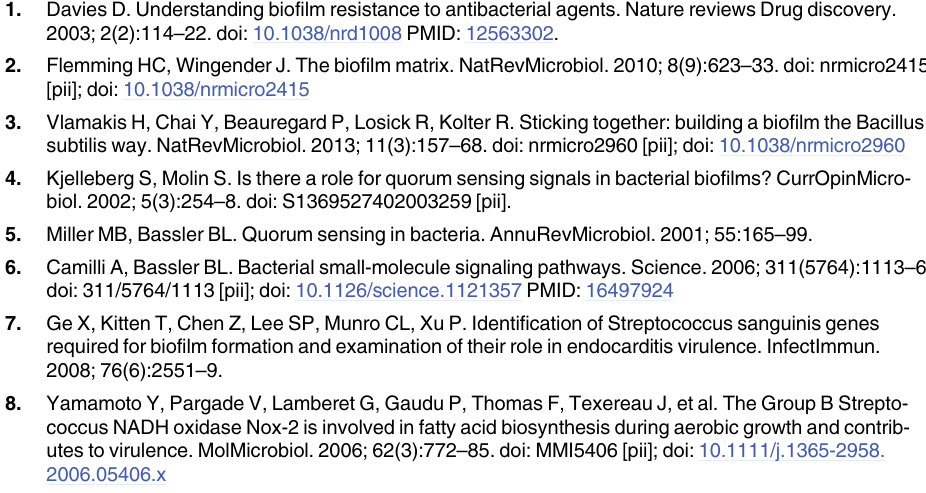
S1 Table. Genes significantly down-regulated and up-regulated in the nox mutant and restored in the nox complemented